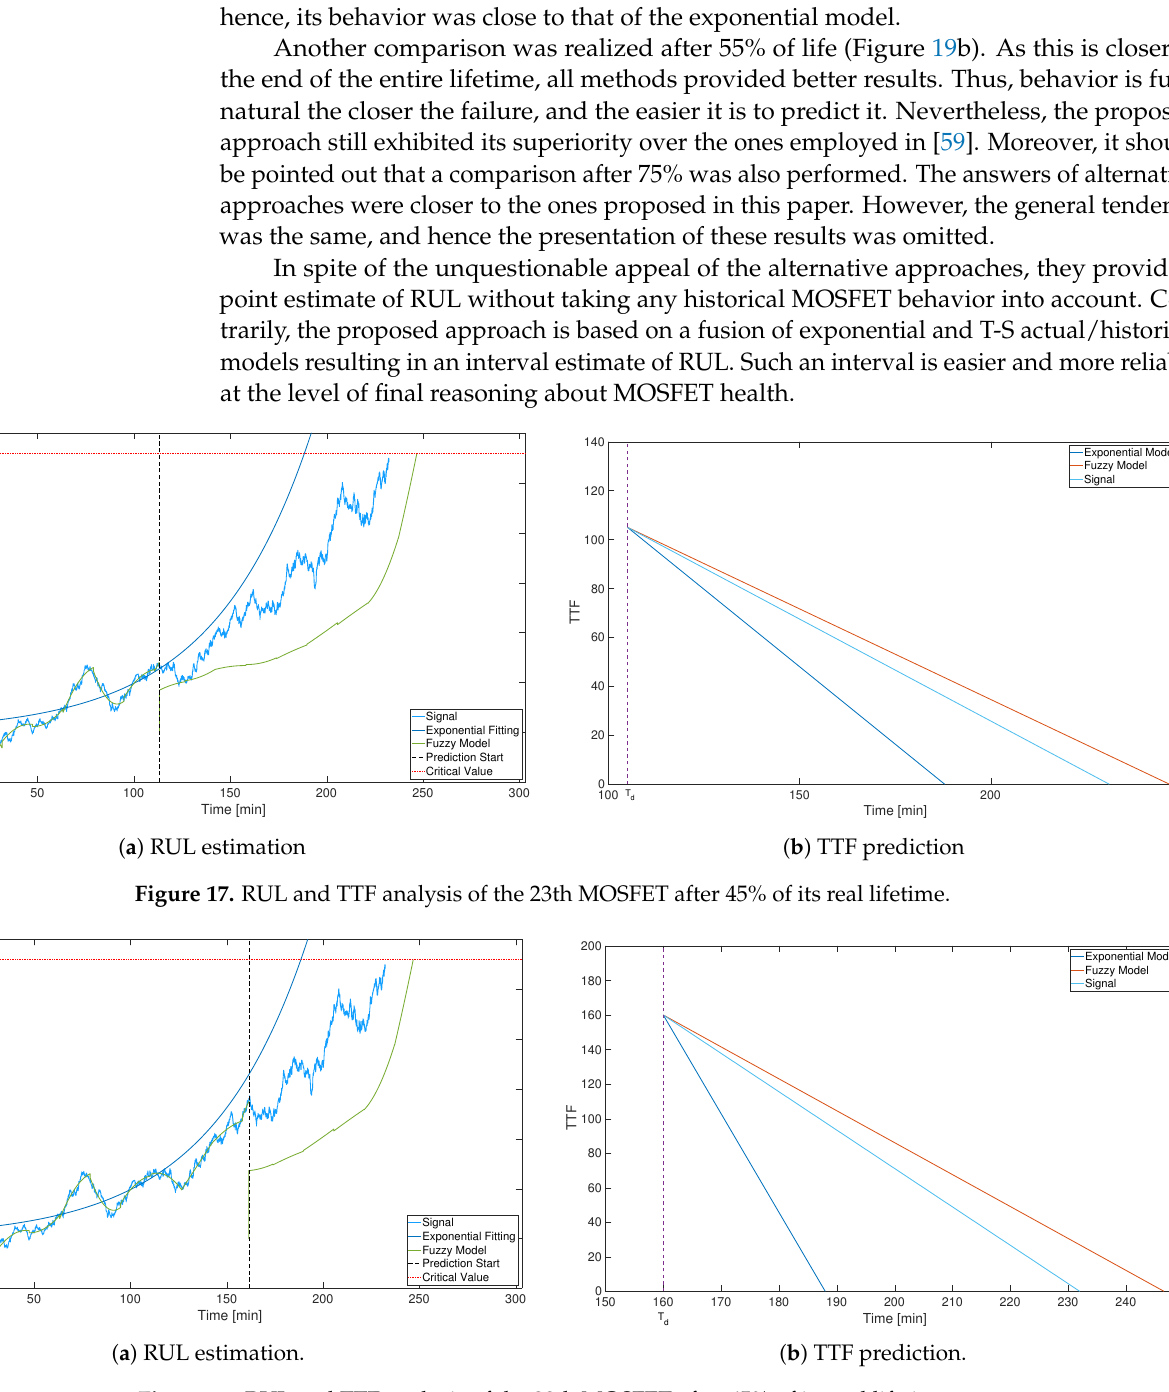
Figure 18. RUL and TTF analysis of the 23th MOSFET after 65% of its real